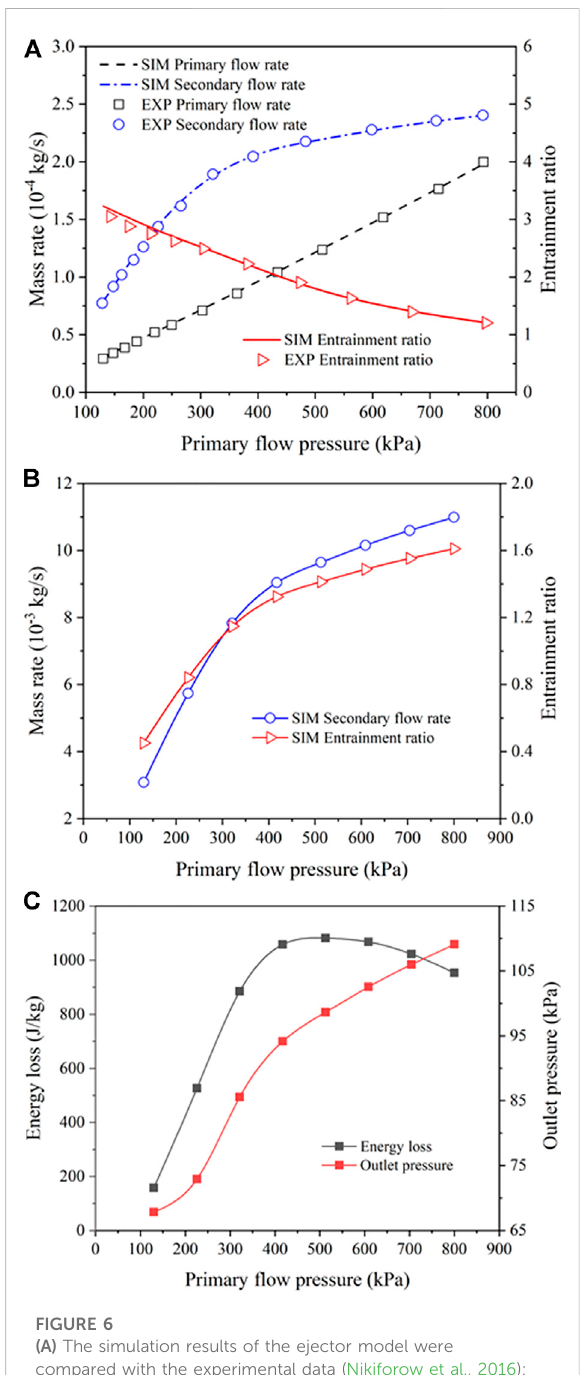
FIGURE 6 (A) The simulation results of the ejector model were compared with the experimental data (Nikiforow et al., 2016); Primary fl owpressurepairofejector (B) m S0 and w ; (C) Energyloss and outlet gas